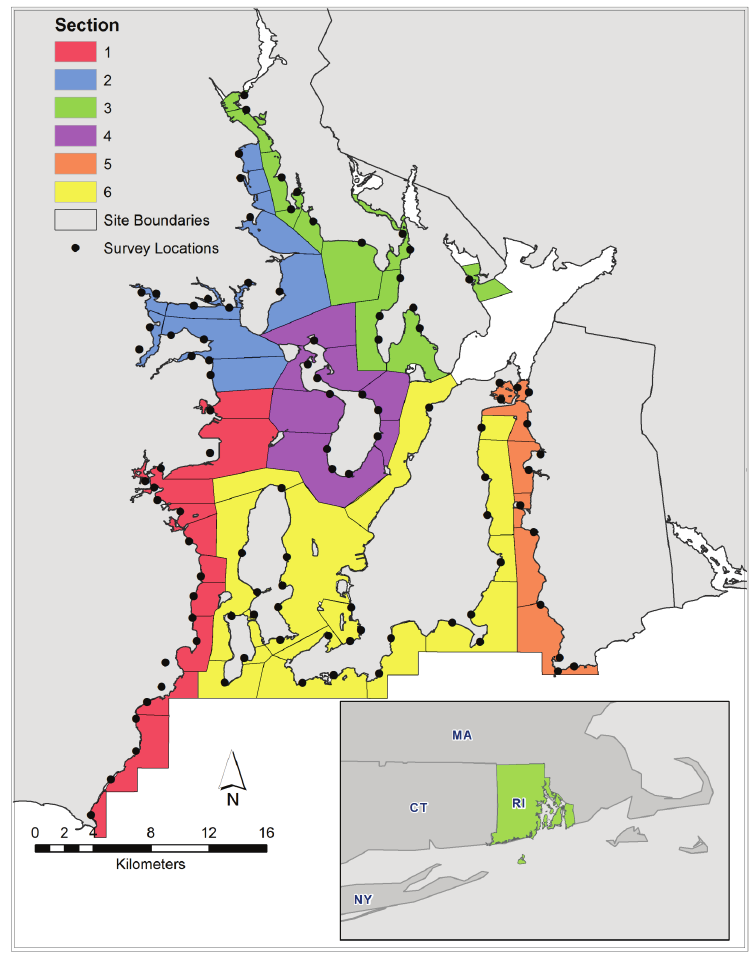
Figure 1. Map of Narragansett Bay, Rhode Island. Inset of Rhode Island (USA). Sections are color-coded and site boundaries delineated. The points represent the approximate observation locations for the